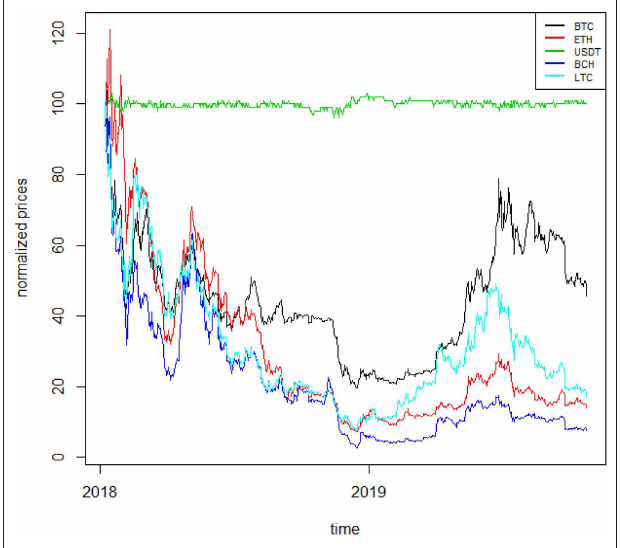
relative to the period 7 January 2018–17 October 2019.